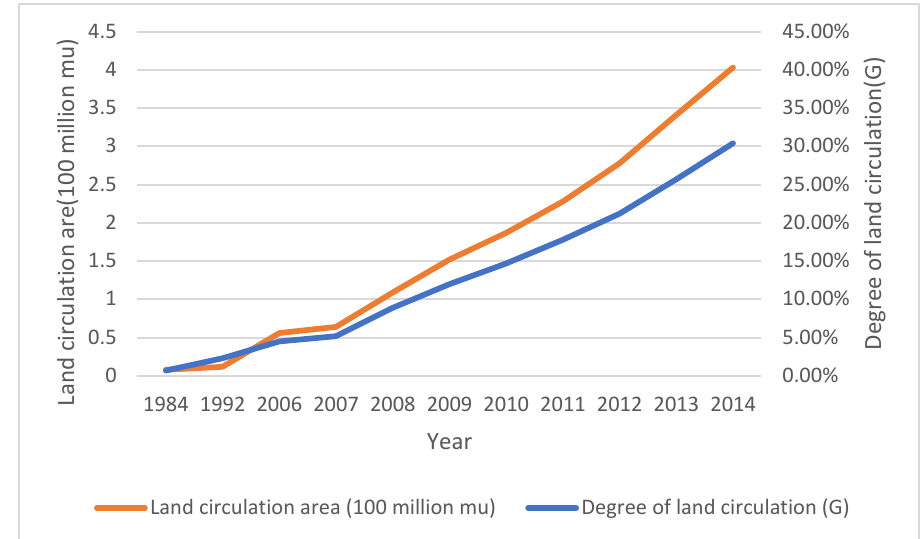
Figure 2. The scale of land circulation in China from 1984 to 2014. Note: calculated according to the annual statistical report of China’s rural policies and reforms and the statistics of the Ministry of Agriculture, where the degree of land circulation is the proportion of the circulation land area to the total cultivable land area.